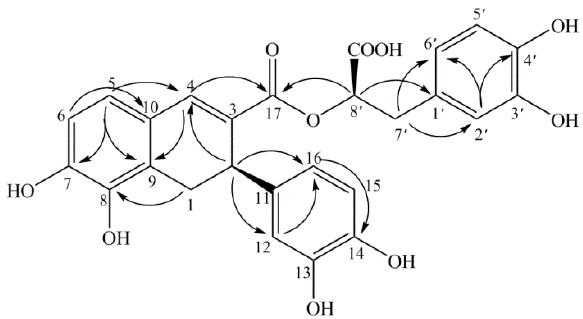
Figure 2. Key HMBC correlations (H → C) in compound 1